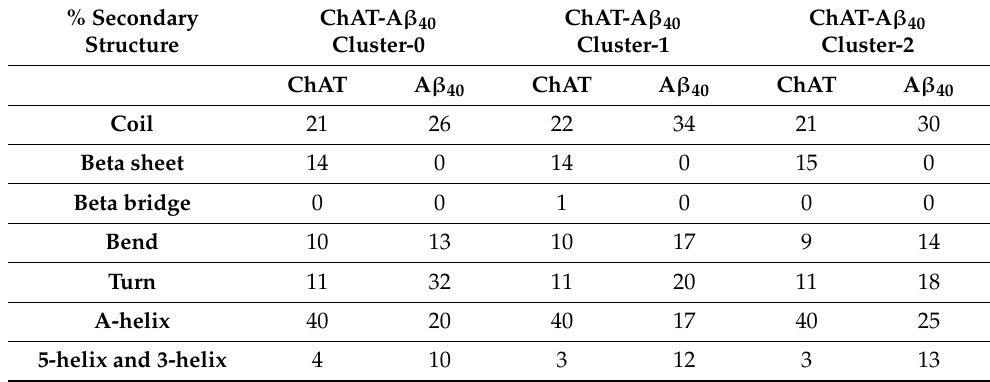
Table 2. Average secondary structure across the trajectory clusters of A β 40 on ChAT.